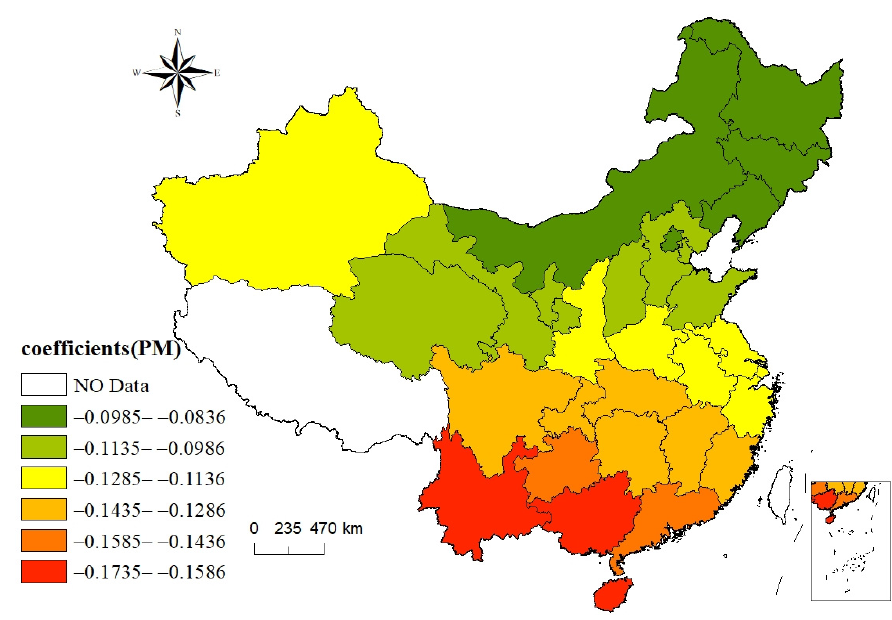
Figure 6. The impact of hydropower on provincial haze pollution in 2017.